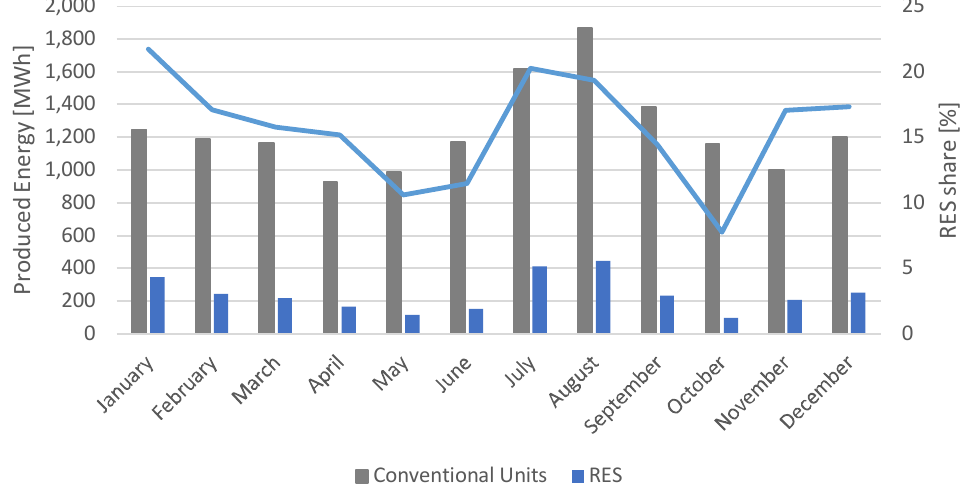
Figure 3. Energy production from conventional units and renewable energy sources (RES) in Patmos in 2020.